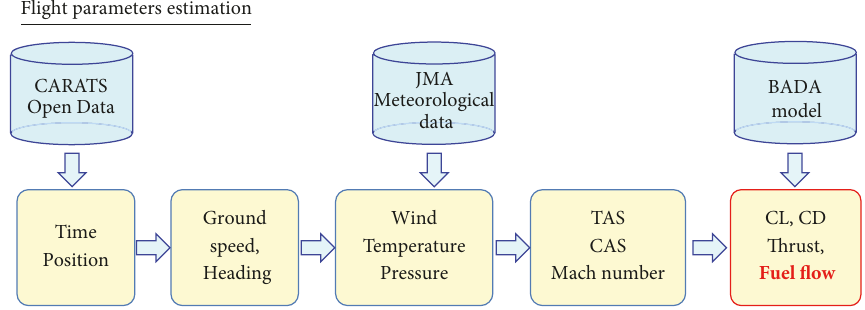
Figure 1: Flow of flight parameters